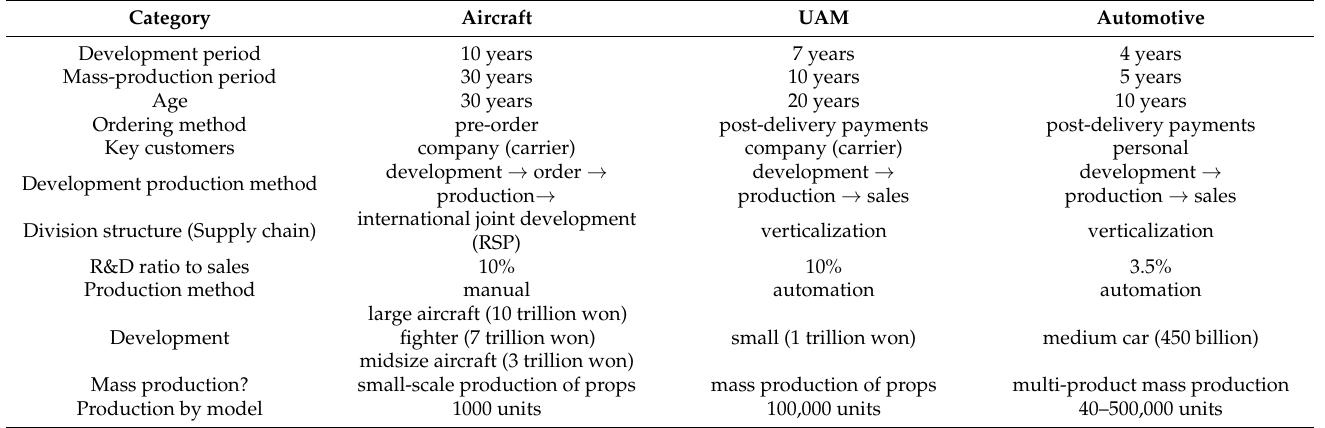
Table 3. Comparison of aircraft, UAM, and automotive industries.